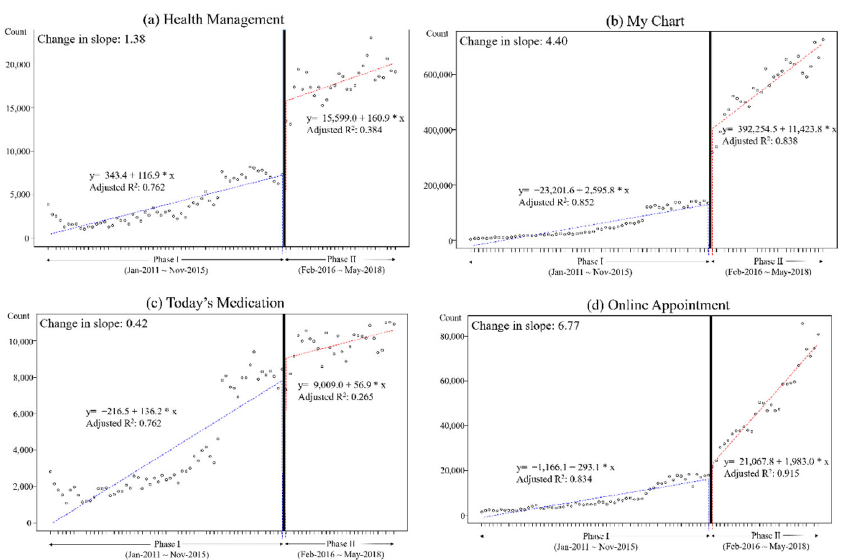
Figure 3. Segmented regression plots of the monthly access counts of ( a ) “Health Management” menu, ( b ) “My Chart” menu, ( c ) “Today’s Medication” menu, and ( d ) “Online Appointment” menu.